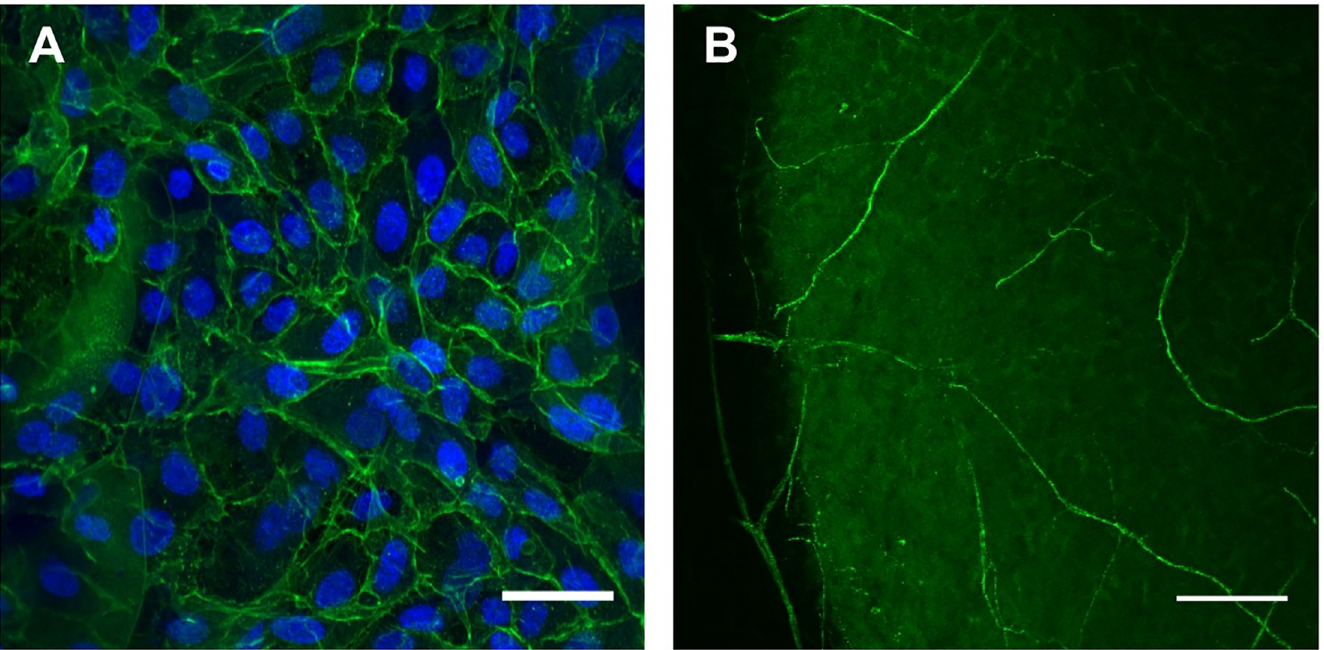
Fig 6. Confirmation of in vitro recellularization of porcine scaffold. A) Human corneal epithelial cells on the scaffold surface (blue = nuclei stained with DAPI, green = F-actin). Scale bar = 50 μ m. B) Rat DRG β III-tubulin-positive neurites permeate the scaffold. (Scale bar = 100 μ m).